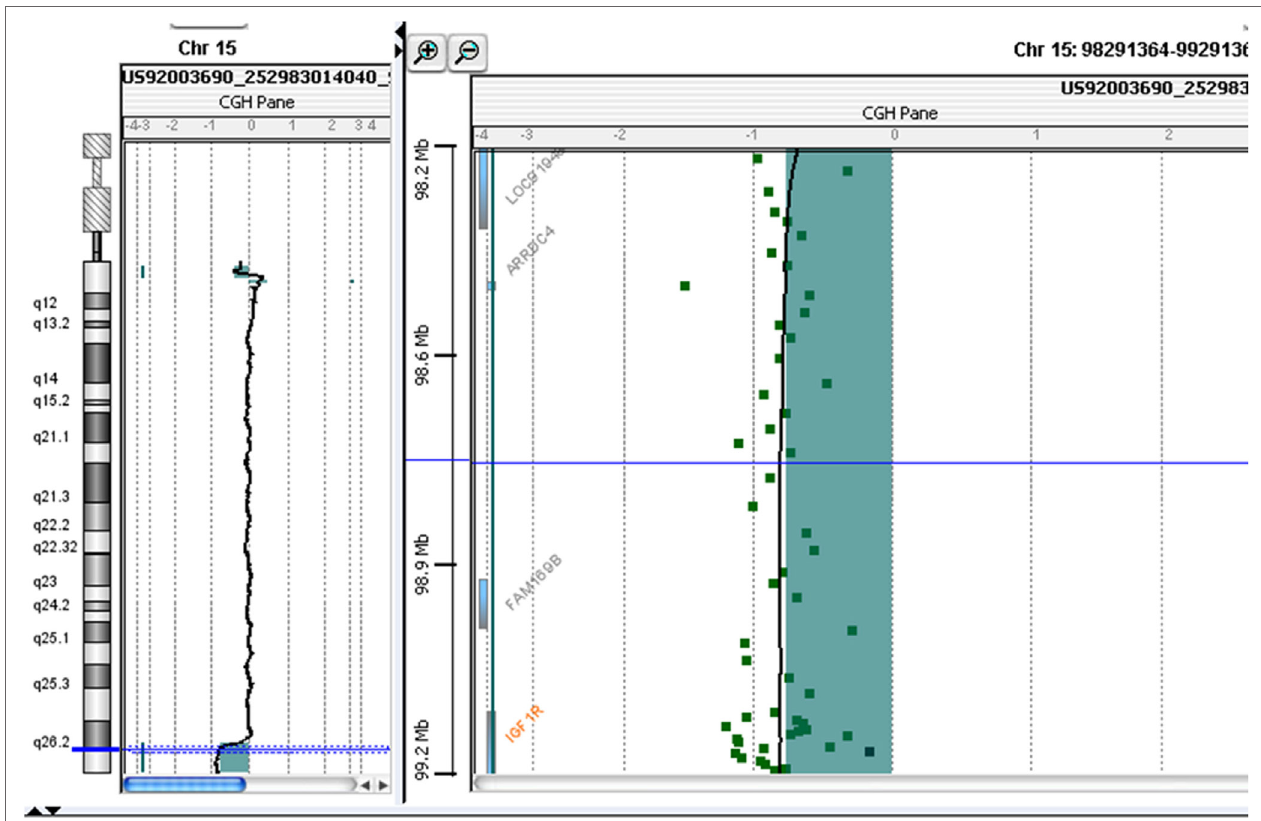
FIGURe 2 | Molecular karyotyping was performed by array-CGH on the proband’s DNA using an Agilent 60 K array platform with a resolution of approximately 100 kb. Based on the physical mapping positions of the February 2009 Assembly (GRCh37/hg19) of the UCSC Genome Browser, this analysis showed a deletion of approximately 4,942 Mb that involved the 15q26.2-q26.3 region, with the breakpoint falling between 97,457,185 bp (first deleted oligomer) and 102,399,819 bp (last deleted